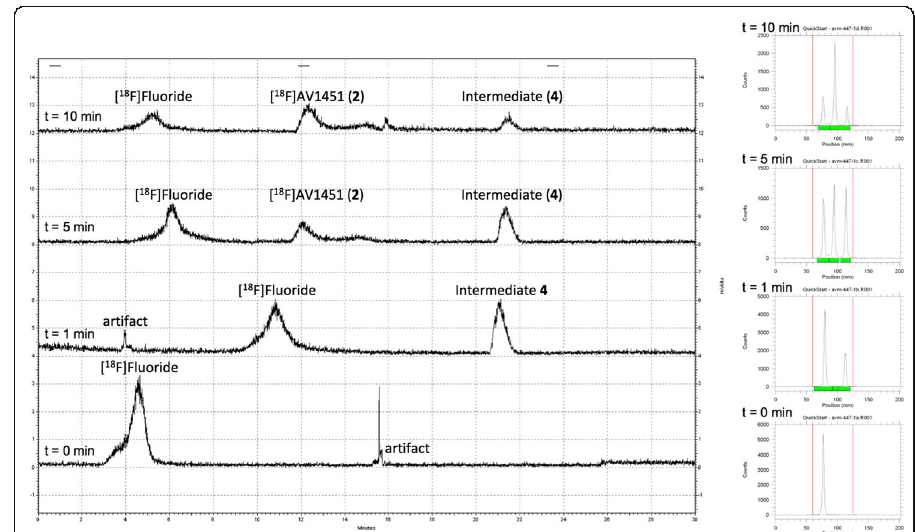
Fig. 6 Radio-TLC (right) and -HPLC (left) data from manual [ 18 F]AV1451 radiolabeling reactions, showing formation of the [ 18 F]-N-Boc-protected intermediate 4 , followed by the [ 18 F]AV1451 product 2 . Aliquots were pulled at t = 0, 1, 5, and 10 minutes and analyzed using both methods [Radio-TLC analysis was performed using a Bioscan AR 2000 Radio-TLC scanner with EMD Millipore TLC silica gel 60 plates (3.0 cm wide x 6.5 cm long) developed using hexane:ethyl acetate (1:1); Radio-HPLC analysis was performed using a Shimadzu LC2010 HPLC equipped with radioactivity and UV detectors (column: Luna C18 5 micron 4.6x150 mm; MeCN:H 2 O gradient: 5:95 (0 – 3 min) – 5:95 → 95:5 (3 – 20 min) – 95:5 → 5:95 (20 – 30 min); flow